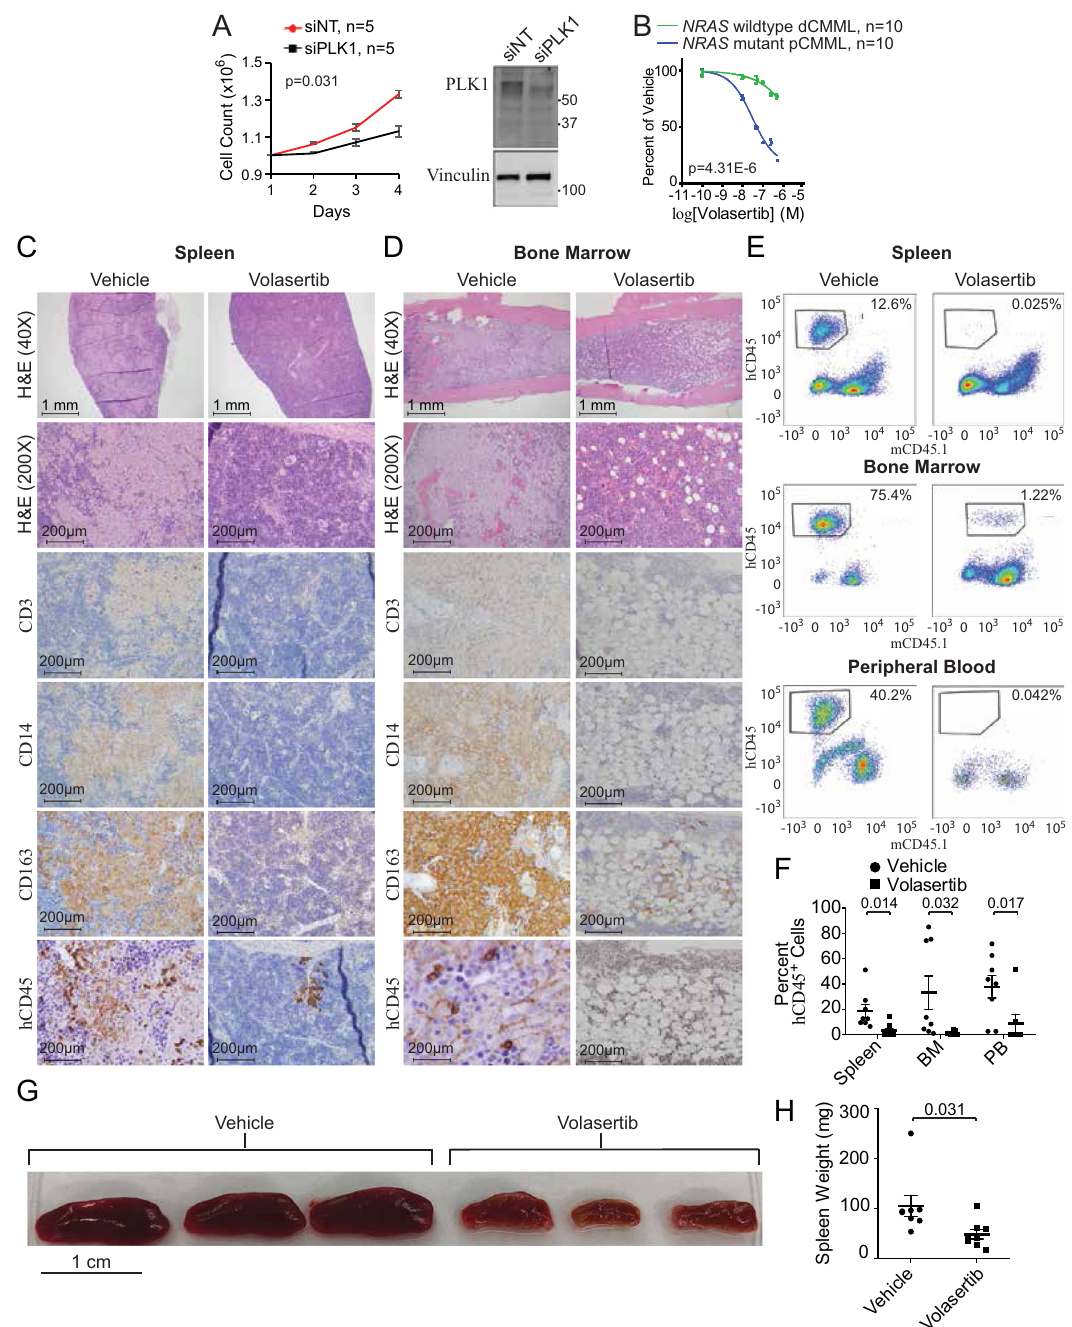
Fig. 7 Therapeutic ef fi cacy of targeting PLK1 in pCMML. A Daily cell counts of CMML MNC after transfection with either siNT or siPLK1. Representative western blot depicts validation of PLK1 knockdown from three experiments. Knockdown of PLK1 by qPCR was ≥ 90%. B Progenitor colony forming assay using CMML MNC with increasing doses of volasertib. Indicated p -value in panels A and B by two-tailed Student ’ s t test. C , D Histopathologic analysis with H&E staining and immunohistochemistry (IHC) of spleen ( C ) and BM ( D ) of murine patient-derived xenografts (PDX) after treatment with vehicle control or volasertib. Magni fi cation is ×200 unless otherwise indicated. hCD45 is human CD45. E Representative fl ow cytometry of spleen, BM and PB of PDXs after treatment with vehicle control (left) or volasertib (right). The y -axis indicates hCD45 expression status while x -axis indicates murine CD45 (mCD45). Percentages indicate proportion of hCD45 + and mCD45- cells in the respective tissues. F Flow cytometry of proportion of hCD45 + cells in spleen, BM, and PB of PDX mice. Data are presented as mean ± SEM from nine mice. G , H Effect of vehicle versus volasertib treatment on PDX spleen size ( G ) and weight ( H ). Data in panel H are presented as mean ± SEM from seven mice treated with vehicle and eight treated with volasertib. Indicated p -value in panels F and H by two-tailed Student ’ s t test. Data in panels A and B are presented as mean ± SEM. The indicated n represents the number of biologic replicates. p -values are indicated with each comparison. Source data are provided as a Source Data fi